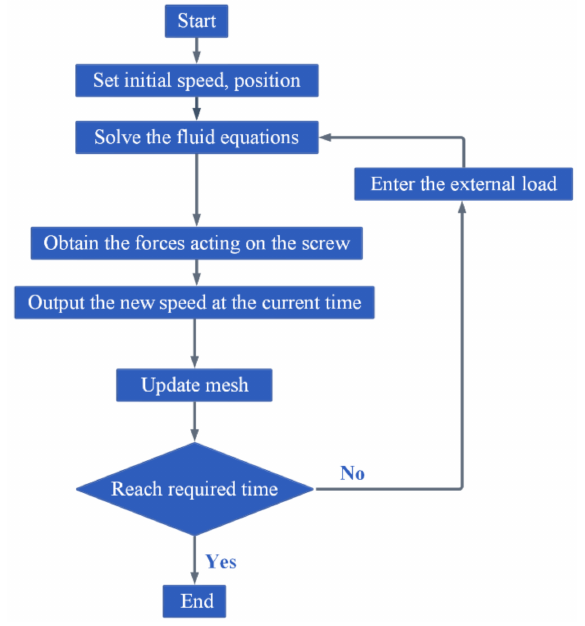
Figure 5. Solving process of dynamics characteristics using the dynamic mesh technology.